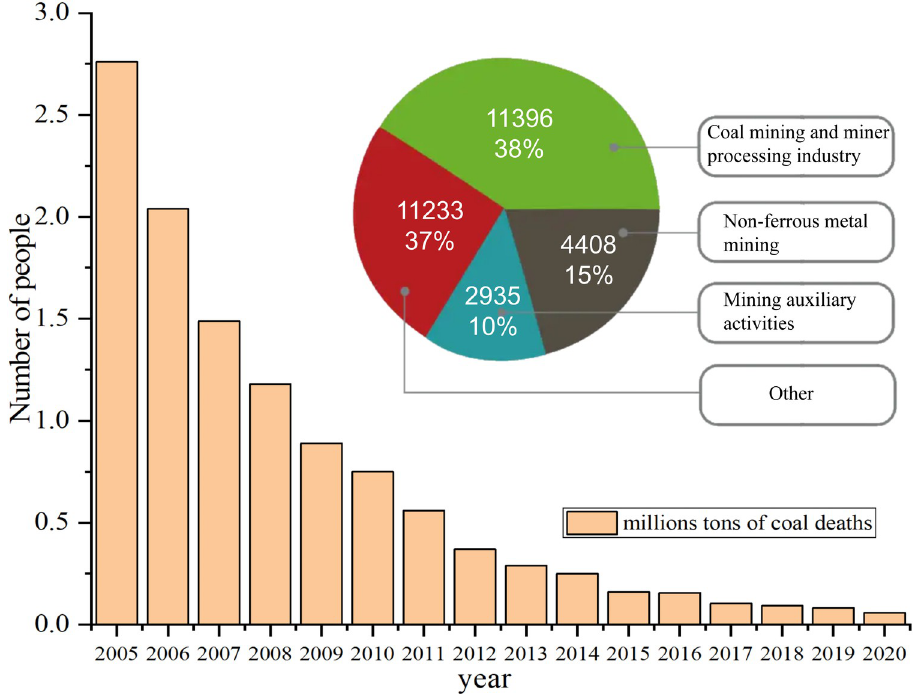
Fig 1. Mining accident fatality rate per million tonnes of coal and pneumoconiosis composition, 2005 to